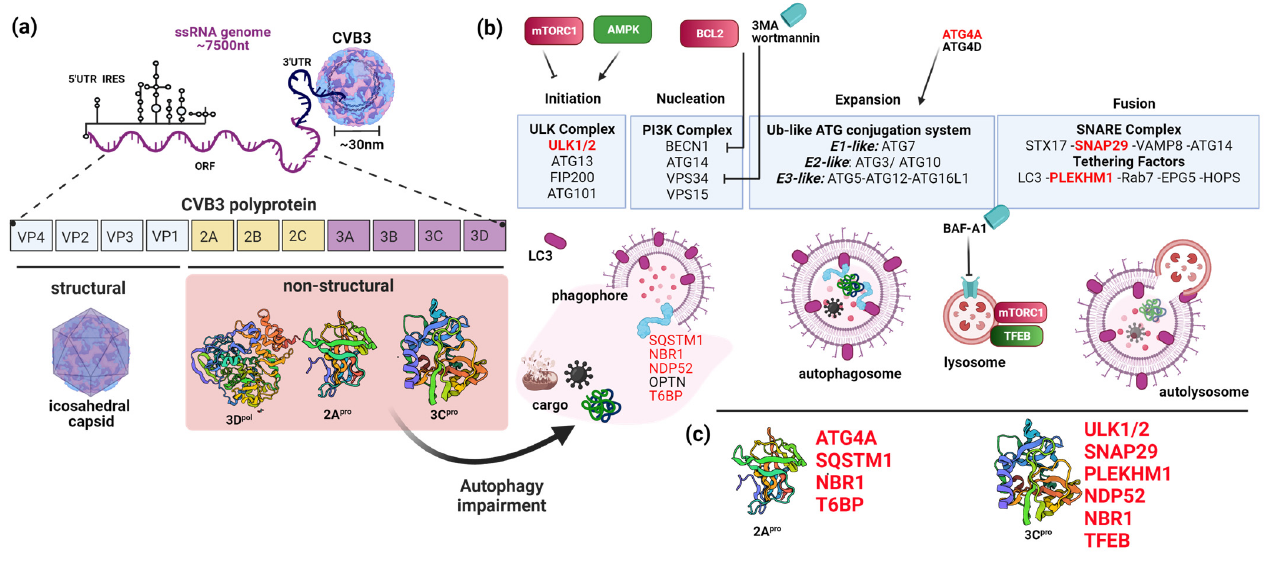
Figure 3. Coxsackievirus B3 (CVB3) Disruption of Cellular Autophagy. ( a ) Schematic depiction of CVB3 structure and proteome architecture. ( b ) Components and process of cellular autophagy beginning with the initiation and nucleation complexes that facilitate autophagosome biogenesis. Maturing autophagosome undergoes expansion via the activity of ubiquitin-like ATG conjugation system. Cargo recruitment inside the developing autophagosomes is mediated by selective autophagy receptors that recognize ubiquitin-modified substrates and bridge with lipidated LC3-II on the autophagic surface. Enclosed autophagosome fuses with lysosomes to facilitate cargo degradation and recycling. ( c ) Viral protease 2A and 3C target key substrates of the autophagy process to impair host cellular recycling and innate immune functions.